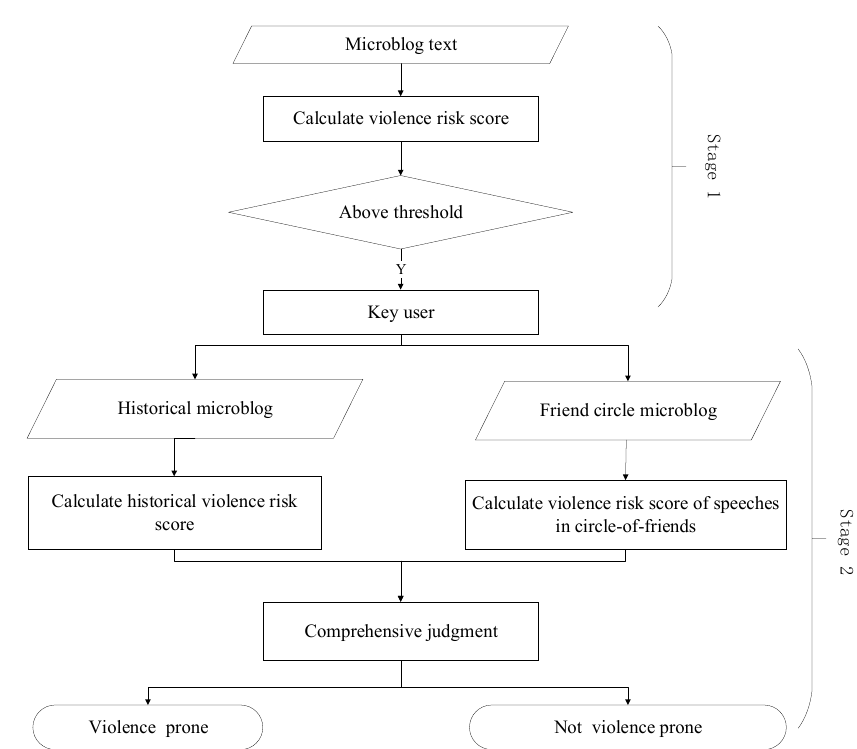
Figure 1. Calculation of comprehensive violence risk.